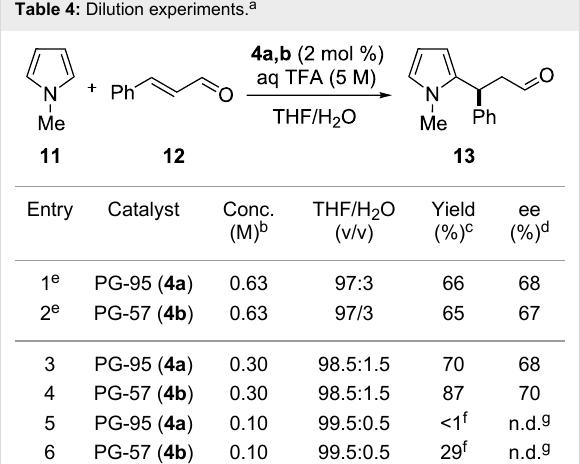
Table 4: Dilution experiments.